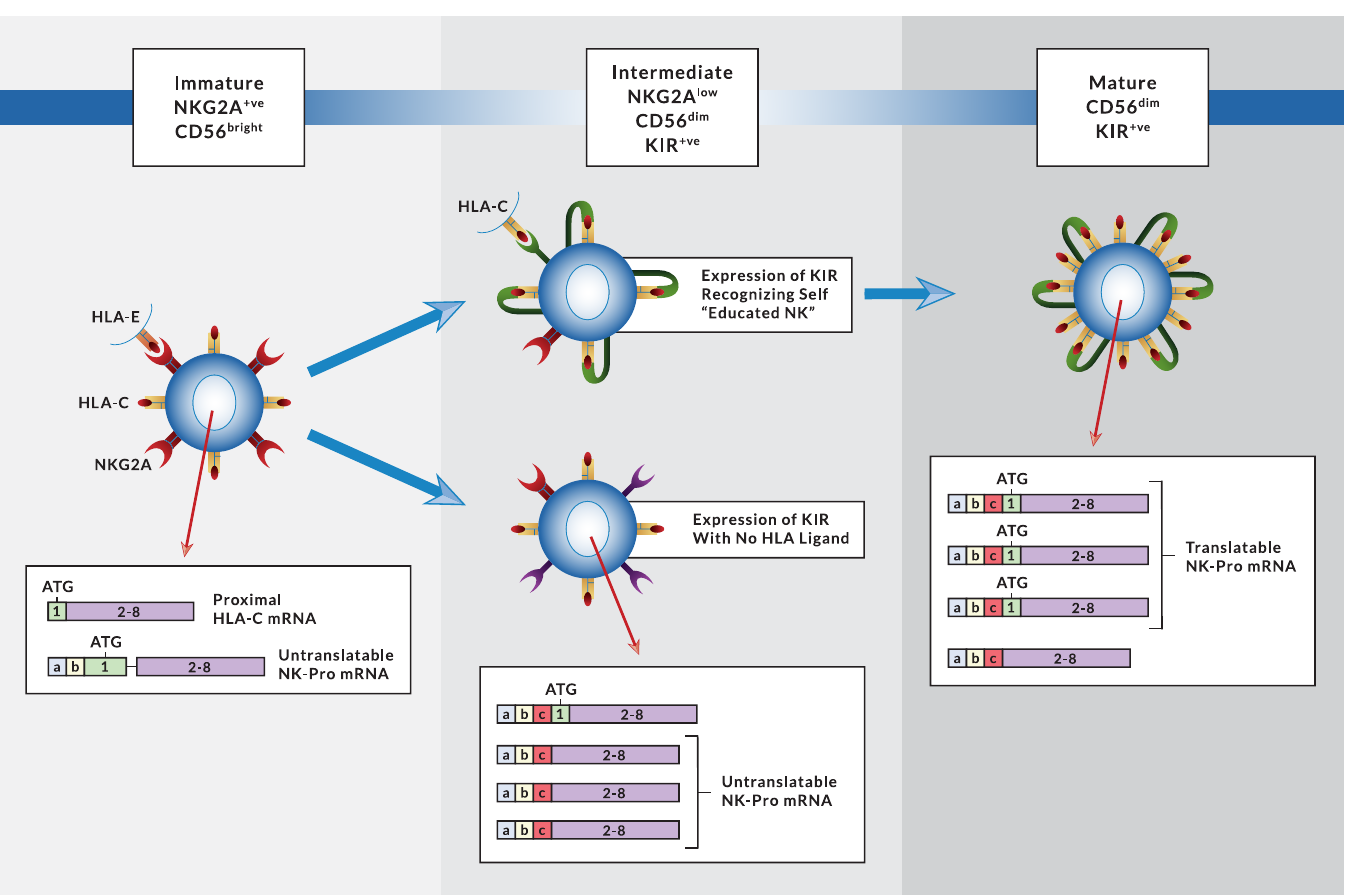
Fig 8. Changes in NK-Pro transcript structure during NK differentiation. The HLA-C transcript profile associated with distinct stages of NK cell differentiation is shown. CD56 bright , immature NK cells express HLA-C primarily from proximal transcripts, as the majority of NK-Pro mRNAs present at this stage are untranslatable. In the intermediate stage, CD56 dim NK cells turn on KIR selectively. A large proportion of the NK-Pro transcripts present at the intermediate stage lack exon 1 and are untranslatable. If a KIR recognizing self HLA is present, the NK cell becomes educated, and develops into a fully mature, highly lytic effector cell. The mature NK cell has increased levels of translatable NK-Pro transcripts, and increased cell surface expression of HLA-C. Inhibition of the NK cell by endogenous HLA-C is indicated by KIR receptor binding to HLA-C in cis, however this would be predicted to occur in endosomes rather than on the cell